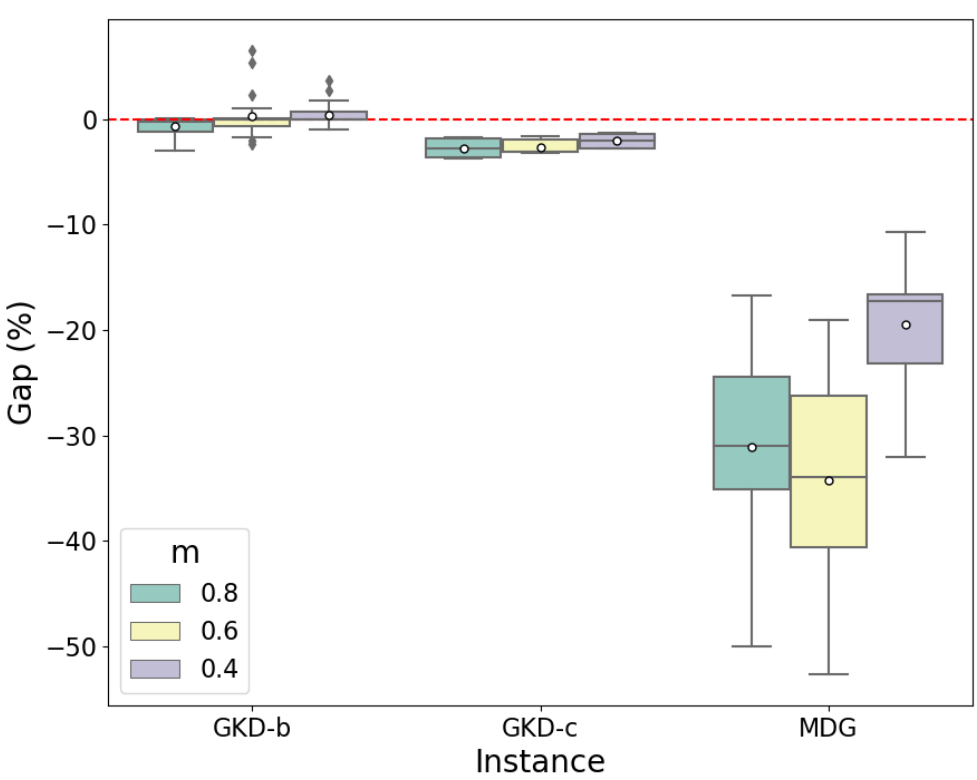
Figure 5. Gaps between our algorithms for different minimum